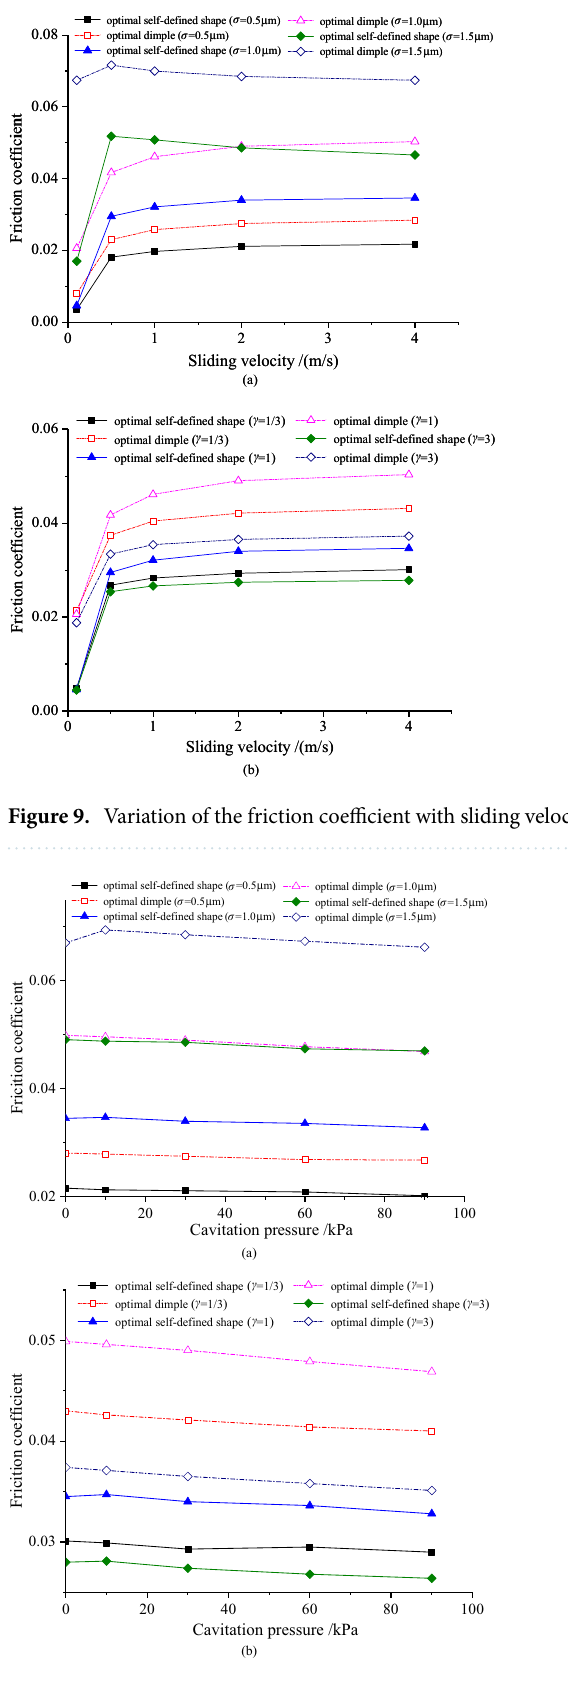
Figure 10. Variation of the friction coefficient with cavitation